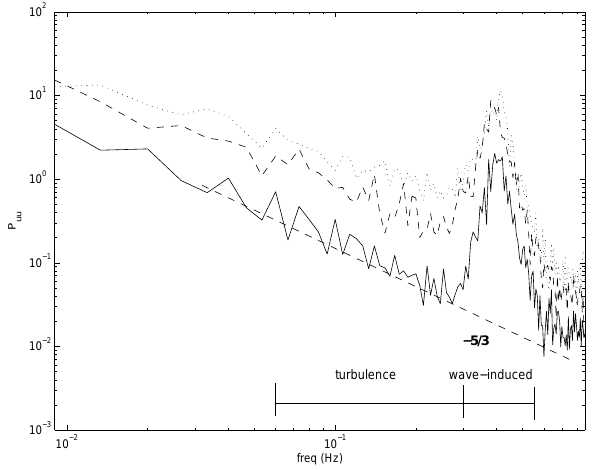
Fig. 3. Fourier wind velocity spectra in the same three episodes as those in Fig.